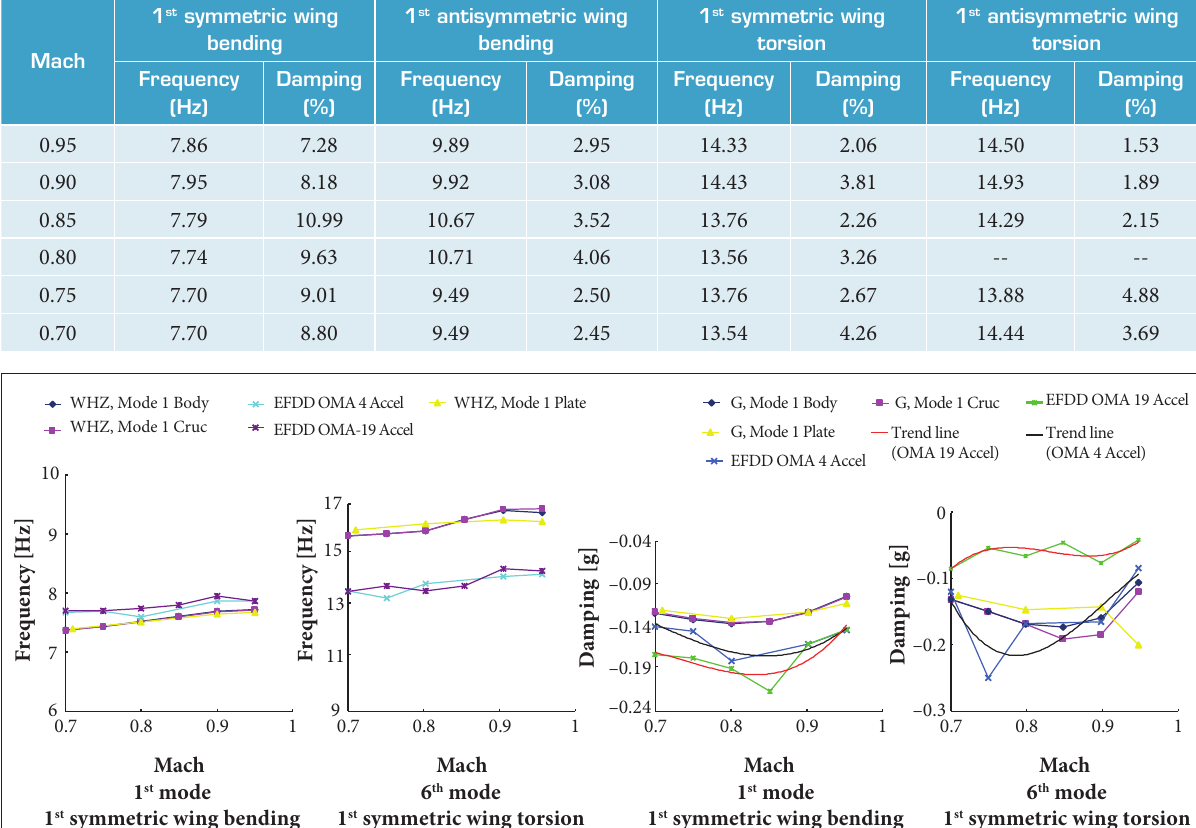
table 2. Identified modal parameters from EFDD/OMA.